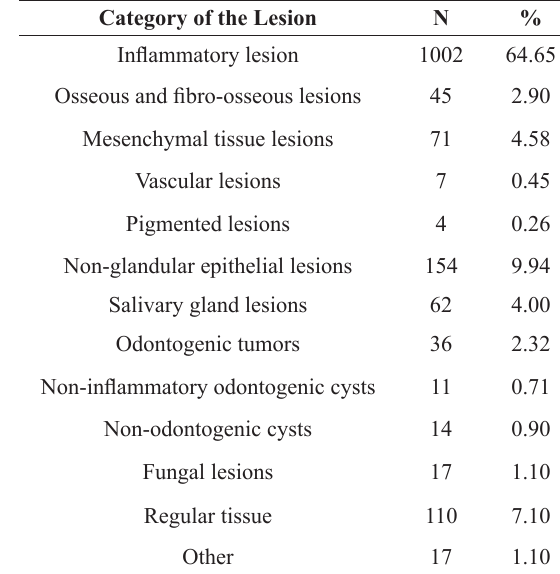
Absolute and relative frequency of lesion